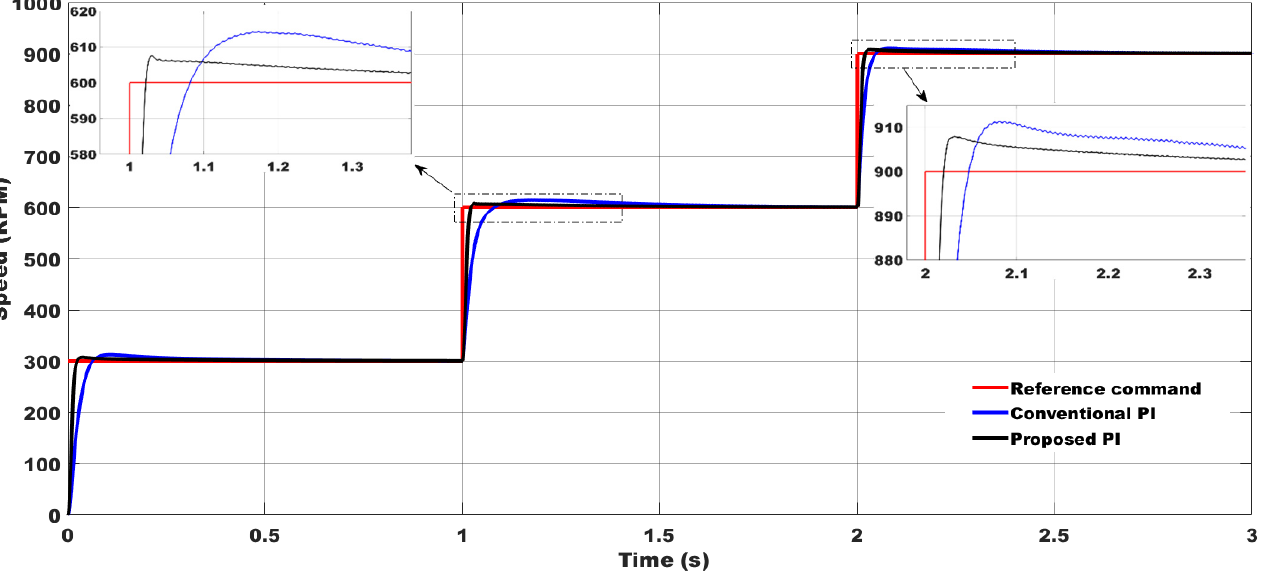
Figure 12. Comparison of robust tracking performance of SynRM drive at various speed ranges.